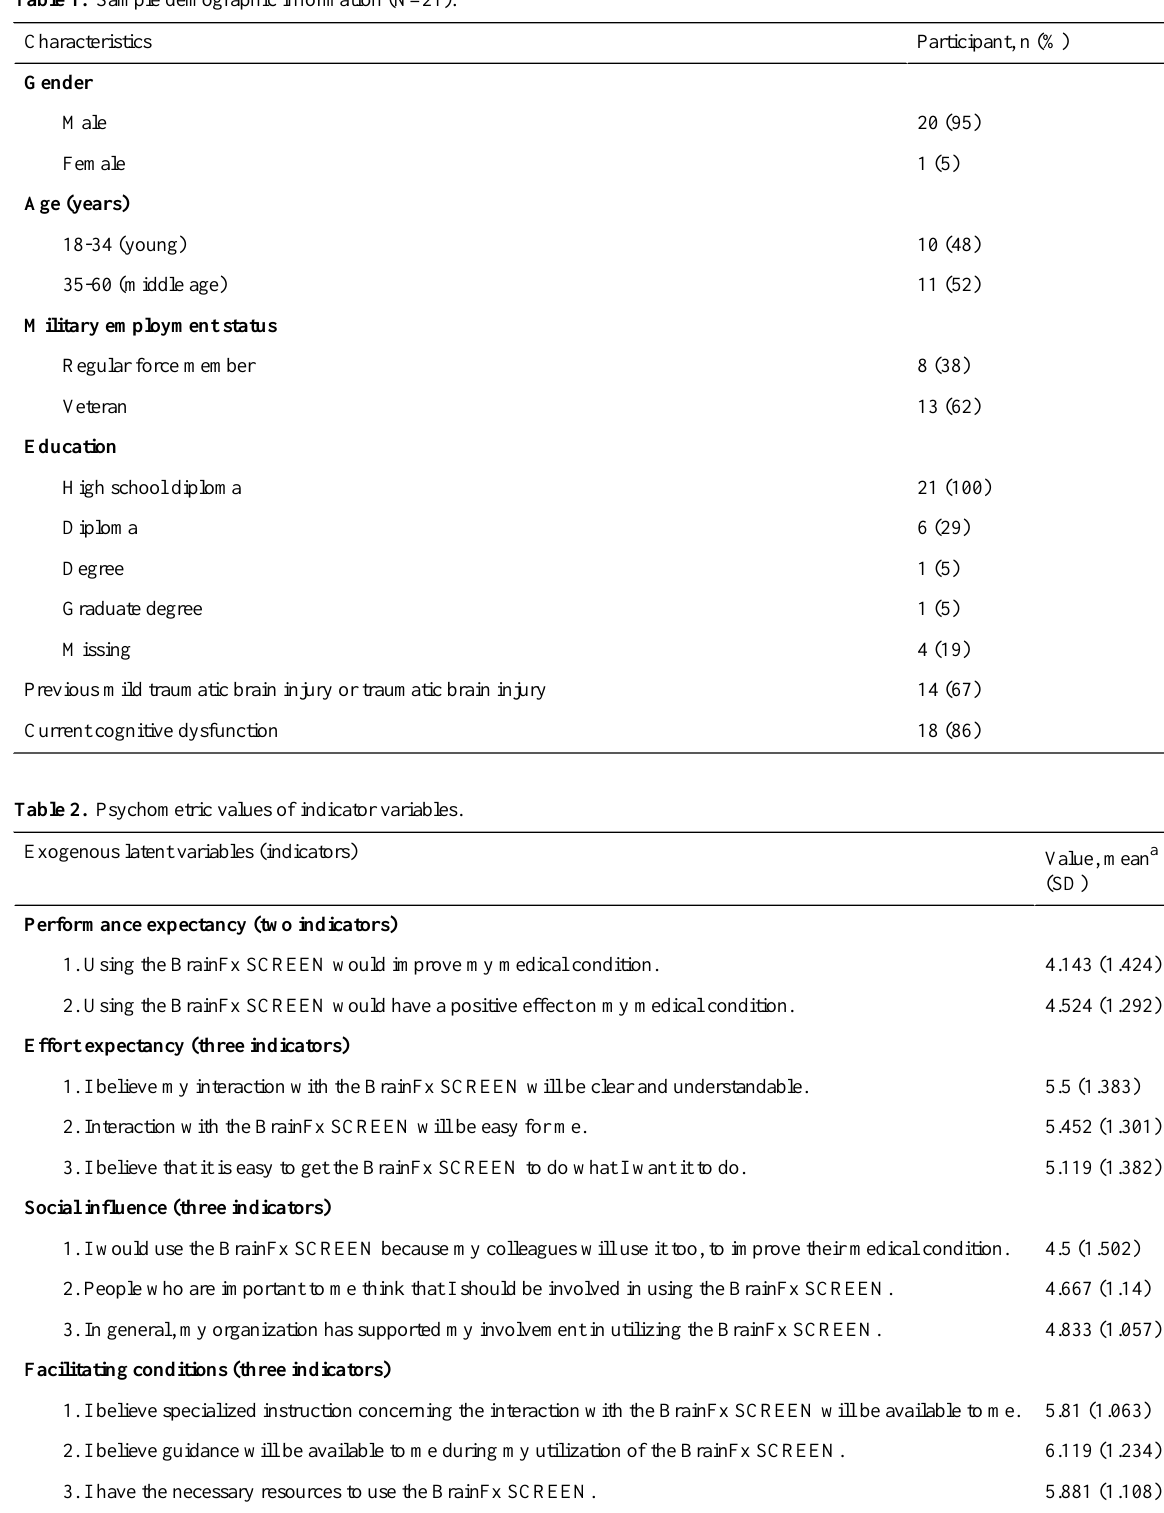
Table 1. Sample demographic information (N=21).